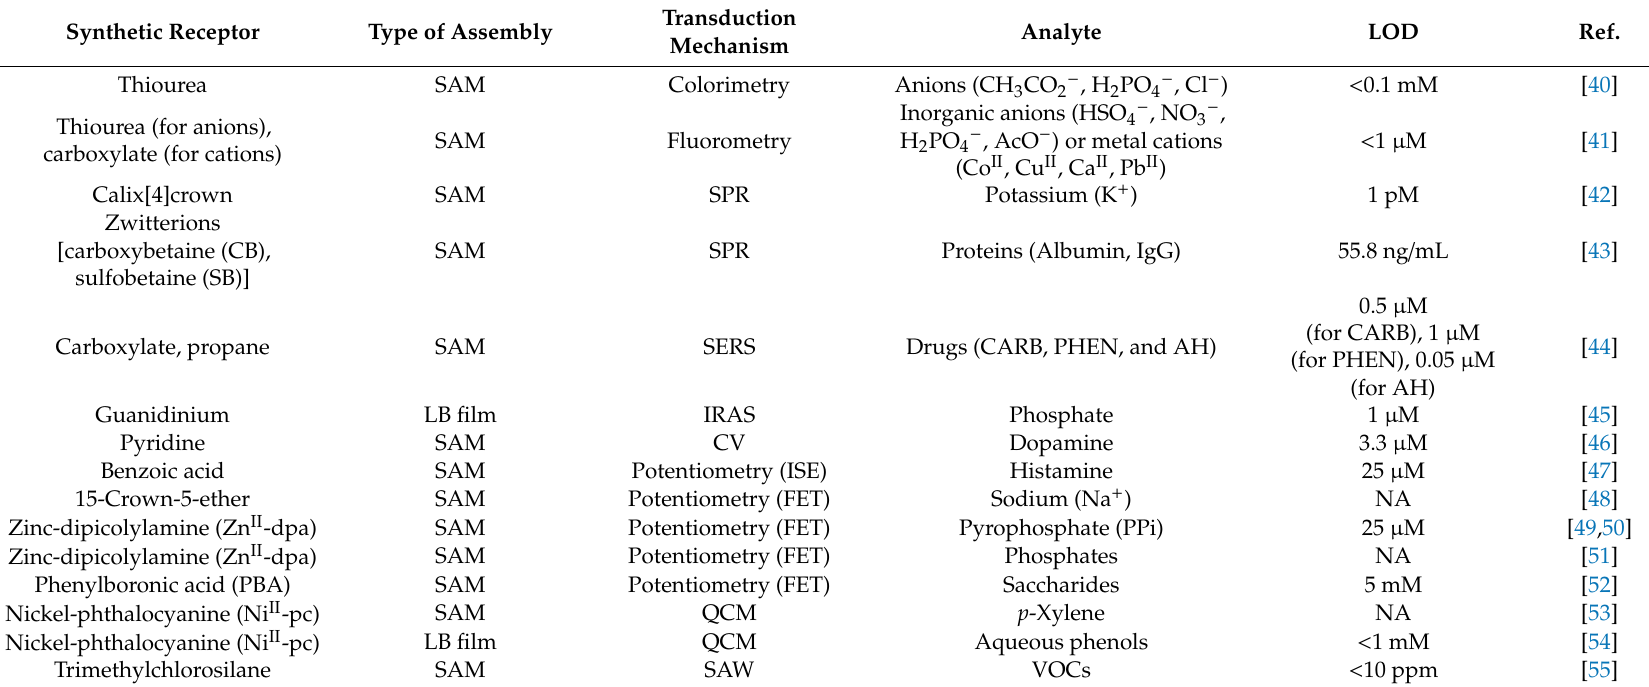
Table 1. Examples of molecular assembly-based